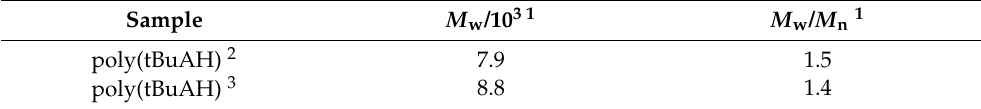
Table 1. Basic characteristics of poly(tBuAH) samples prepared in this